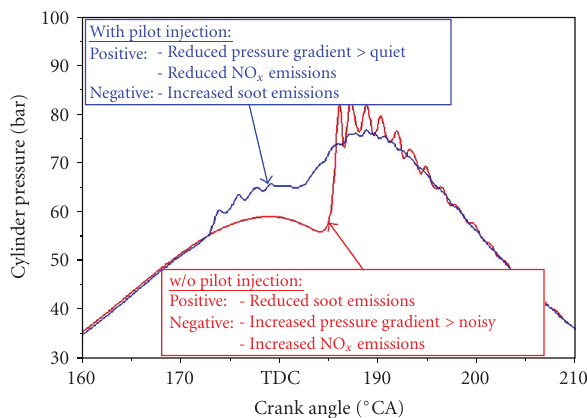
Figure 1: Cylinder pressure with and without pilot injection.